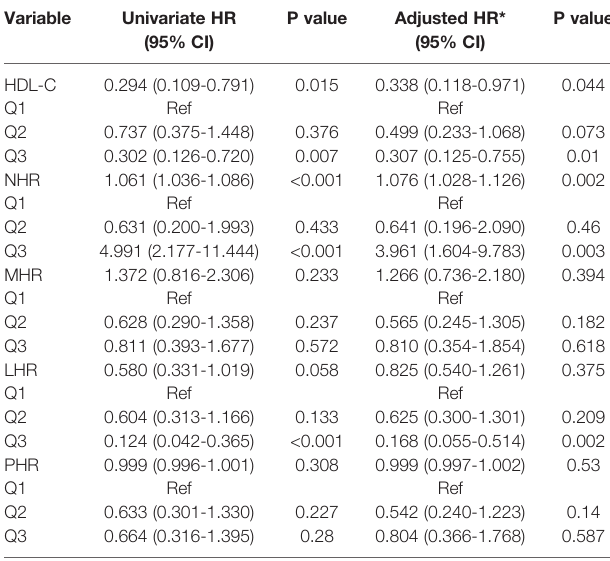
TABLE 6 | Cox proportional hazards regression model for primary end point among diabetic patients with